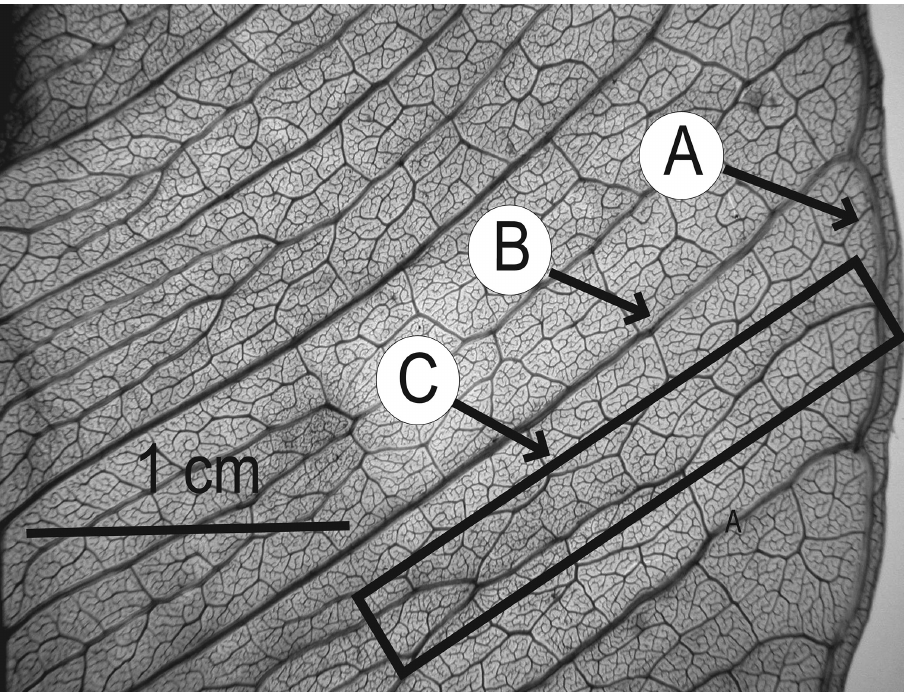
Figure 1. Leaf architecture of Spondias globosa. A Intramarginal vein B Secondary vein course straight C Composite admedial tertiary vein branching from intramarginal (defined by box)(from Vásquez 12866 ,